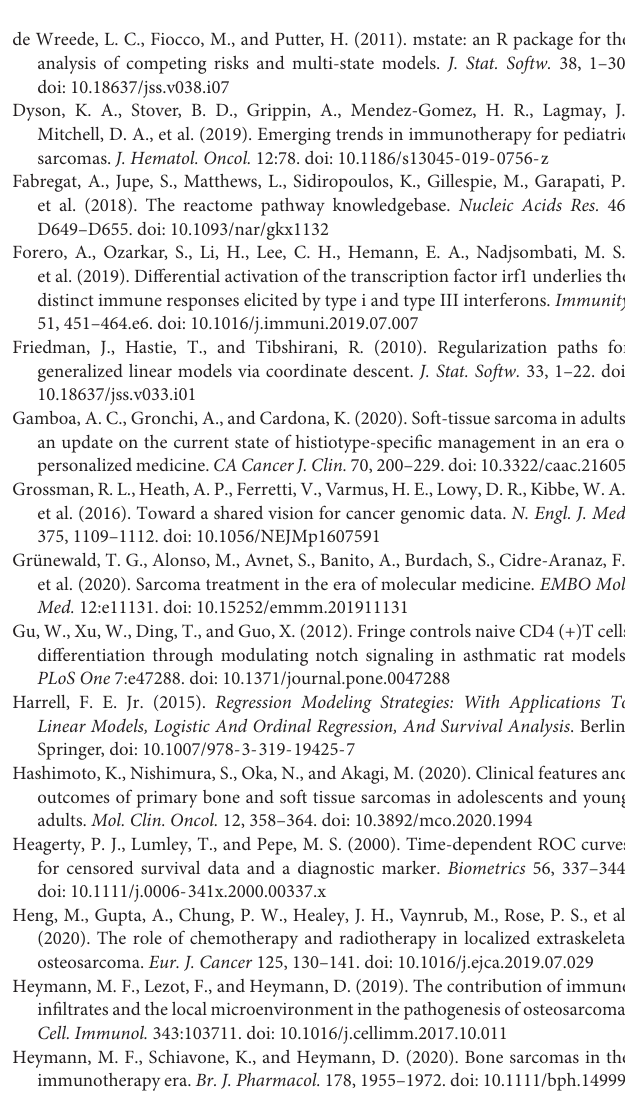
Supplementary Figure 1 | Correlation between immune score and clinical characteristics in TCGA sarcoma patients: (A) tumor depth, (B) local disease recurrence, (C) tumor margin status, (D) radiation therapy, (E) metastasis at diagnosis, (F) tumor total necrosis percent. Supplementary Figure 2 | Heatmap and volcano plot of differentially expressed genes between the high and low immune score groups of the whole annotated RNA-Seq data. Supplementary Figure 3 | (A) Clustering for the detection of outlier samples in WGCNA. (B) Gene dendrogram and plot for the dynamic tree cutting. (C) Clustering of module eigengenes. (D) Eigengene expression in the yellow-green module for each sample. (E) The topological overlap measure (TOM) for gene network connections (left: all genes, right: randomly selected 1000 genes). Supplementary Figure 4 | The total PPI network visualized via Cytoscape. Supplementary Figure 5 | (A–C) Risk score curve, survival status and the gene expression levels for each patient were discretely distributed between two groups in the testing cohort. (D) Time-dependent ROC curves for the risk score model for predicting the survival probability of 1-, 3-, 5-year and median-survival time overall